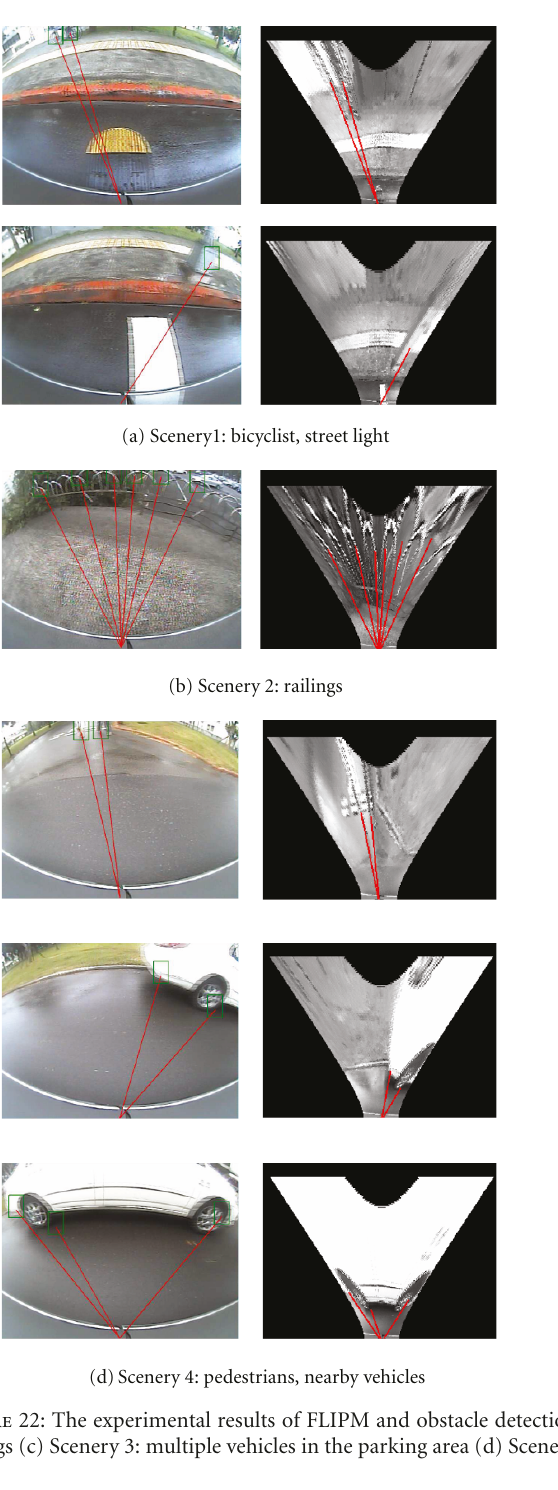
according to the proposed process and approach which have been introduced in the previous sections as